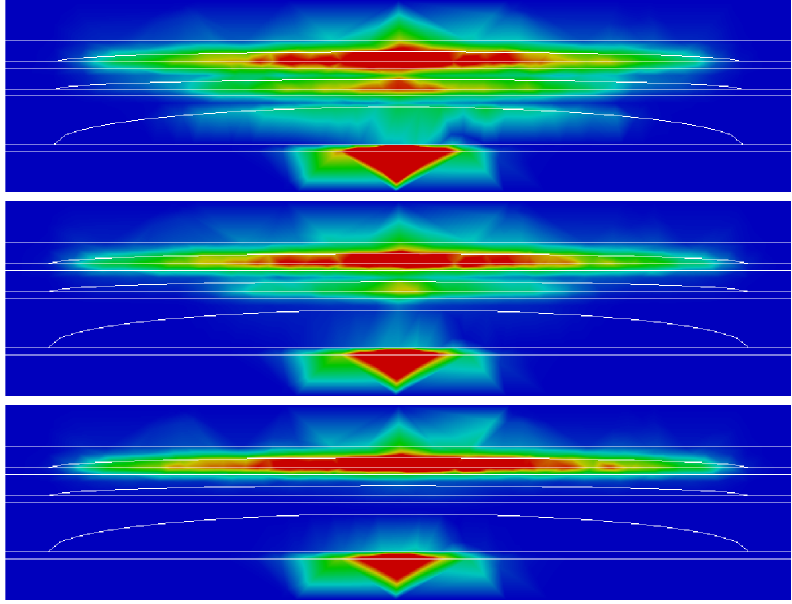
Figure 4. Linear combination of the probability densities of the first three holes states and of the first 100 electronic states in the xz plane calculated for the three different configurations (HML, MMM, LMH from top to